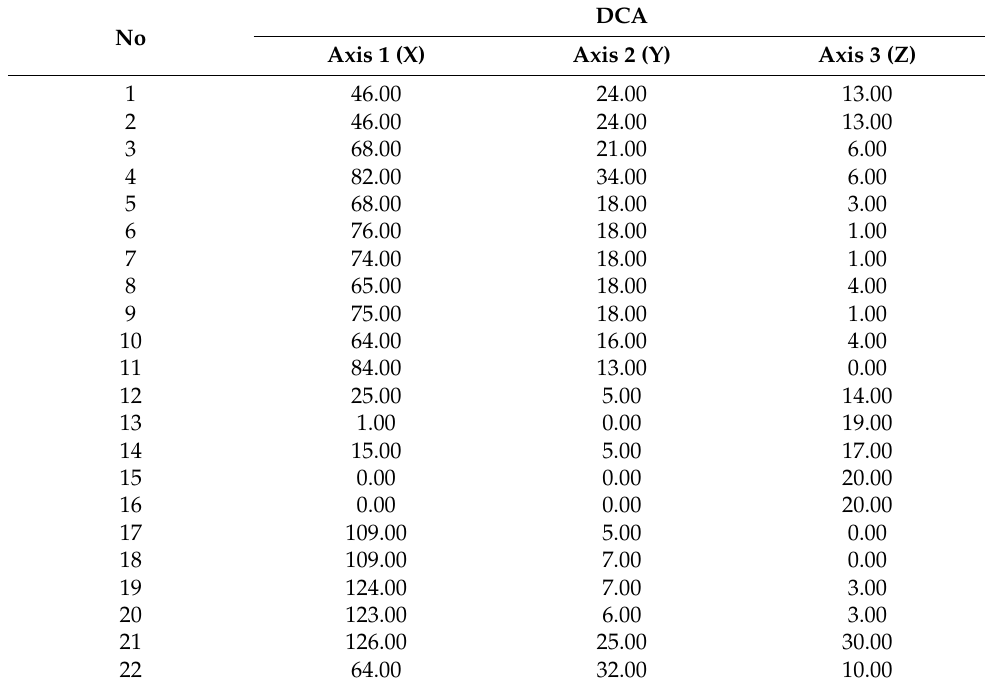
Table 3. Normalized values of DCA for each compared flora. in accordance to the specimen numbers in the Table 2.